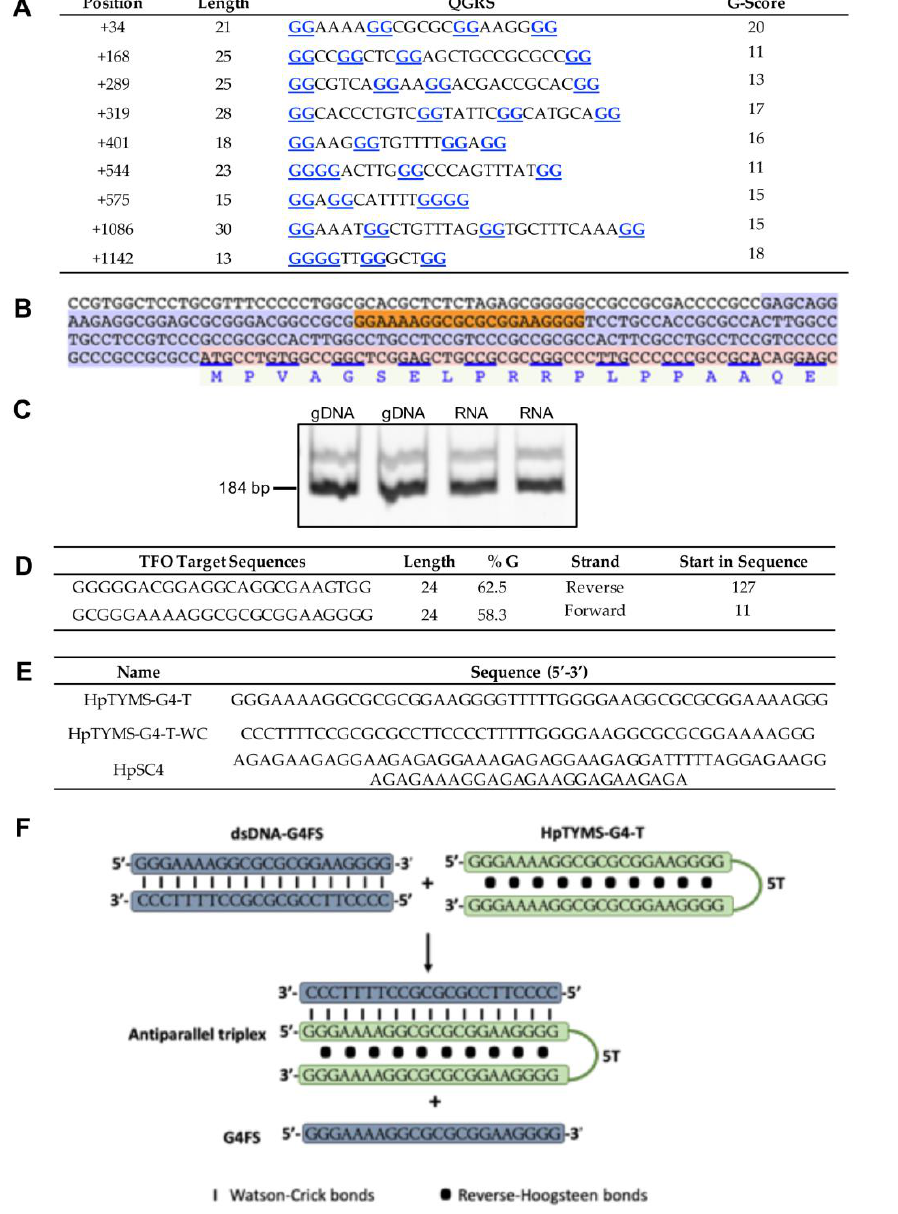
Figure 1. Identification of a G4FS in the TYMS gene and design of a PPRH targeting this site. ( A ) Putative G4-forming sequences detected in the TYMS gene using the QGRS mapper. The positions of the identified G4FS are referred to as the transcription start site considering the TYMS mRNA sequence NM_001071.3. The blue underlined Guanines (Gs) represent the ones implicated in G4 formation. ( B ) Localization of the G4FS with the higher G-score in the TYMS gene sequence (NM_001071.3). The orange highlighted sequence corresponds to G4FS. ( C ) The G4FS is located in the 5’UTR of the TYMS gene. PCR products (184 bp) obtained after amplification with primers 5’UTR-TYMS-Fw and 5’UTR-TYMS-Rv of both gDNA and cDNA / RNA samples. PCR products were resolved in a 6% polyacrylamide gel electrophoresis. ( D ) The first two polypurine sequences found in TYMS mRNA using the TFO searching tool. ( E ) Sequence of the specific PPRH targeting the G4FS (HpTYMS-G4-T), its corresponding Watson–Crick negative control (HpTYMS-G4-T-WC) and a scramble negative control (HpSC4). ( F ) Scheme showing the potential strand displacement produced when the PPRH (HpTYMS-G4-T) is mixed with dsDNA-G4FS. The formation of the antiparallel triplex by binding of the PPRH to the polypyrimidine oligonucleotide dissociates the polypurine